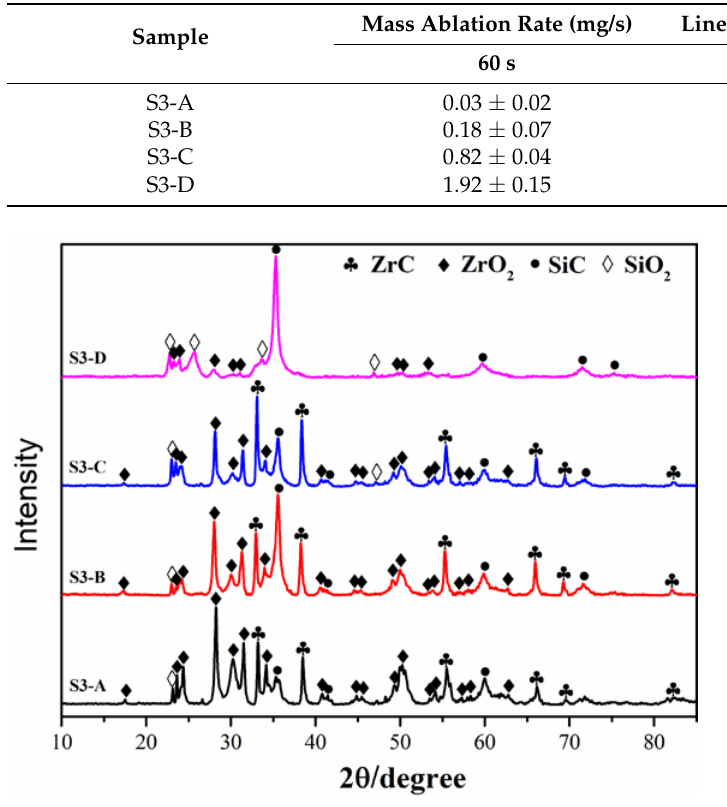
Figure 11. XRD patterns of the S3 coatings after 60 s ablation time.